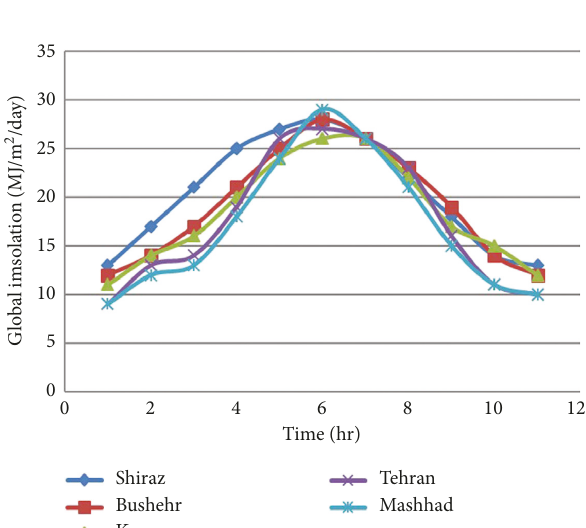
Figure 7: Monthly average temperature changes in different months of the year for selected cities in Iran.